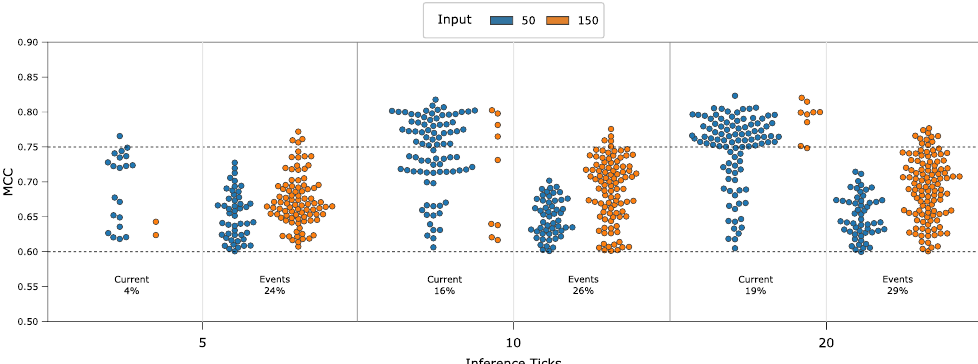
Figure 9. Inference ticks and number of inputs impact on MCC using the Current Input and the Event Input. Each point is a configuration of LSNN, which is characterised by its